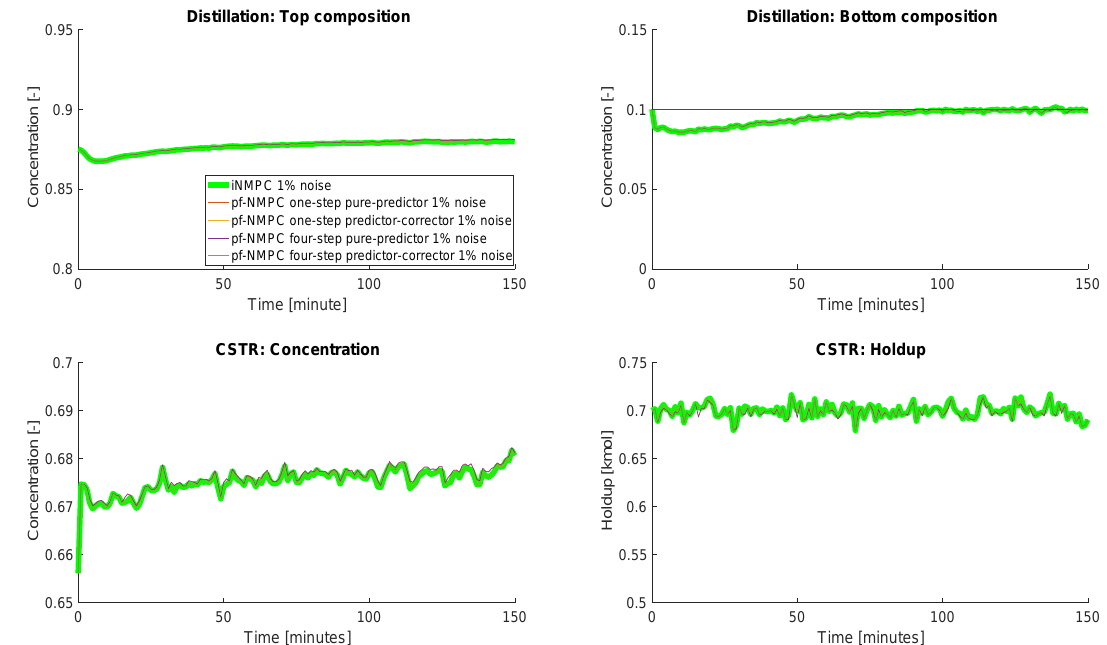
Figure 6. Recycle composition, bottom composition, reactor concentration and reactor holdup. Table 5. Comparison of economic NMPC controllers. Accumulated stage cost is in $.